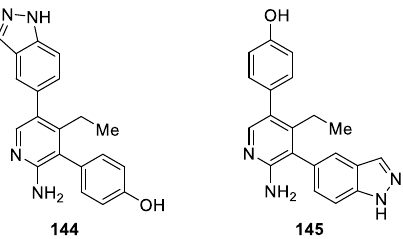
Figure 39. Chemical structures of 1 H -indazole derivatives 144 and 145 .